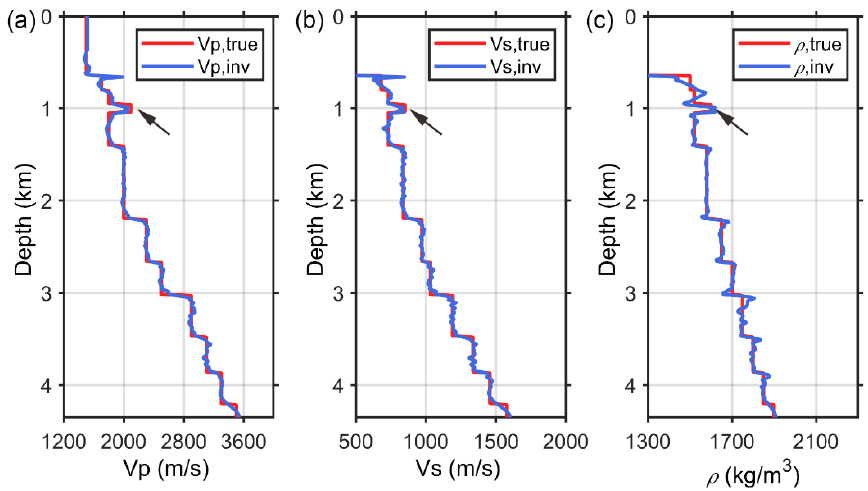
Figure 14. The inverted models from the noisy data using the wave-equation-based inversion method: ( a ) P-wave velocity, ( b ) S-wave velocity, and ( c ) density. The black lines indicate the strat- igraphic horizons and the red lines indicate the faults.